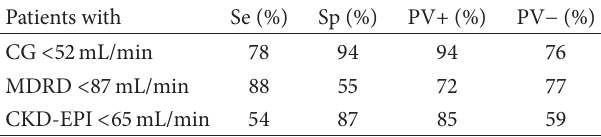
Table3:DiagnostictestsofthreeestimatingGFRformulasforCKD.